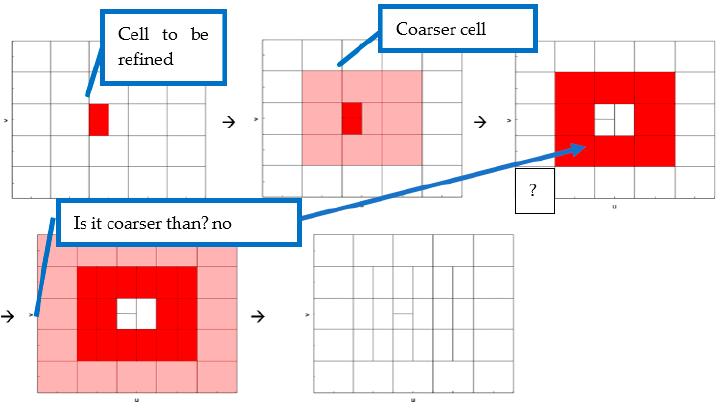
Figure 3. Example of refinement: The patch marked (pink) contains elements that are coarser than the cell to be refined (red). The algorithm checks their patches for even coarser elements and stops after two iterations.